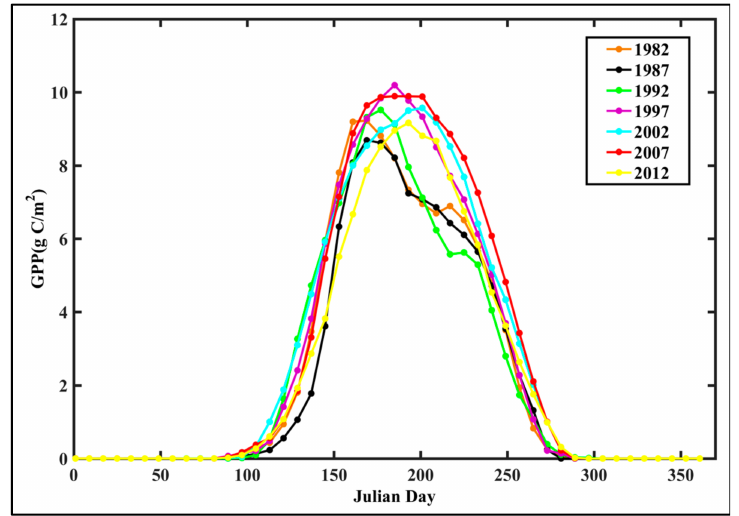
Figure 3. Intra-annual variation characteristic of gross primary productivity (GPP) values during 1982–2015.